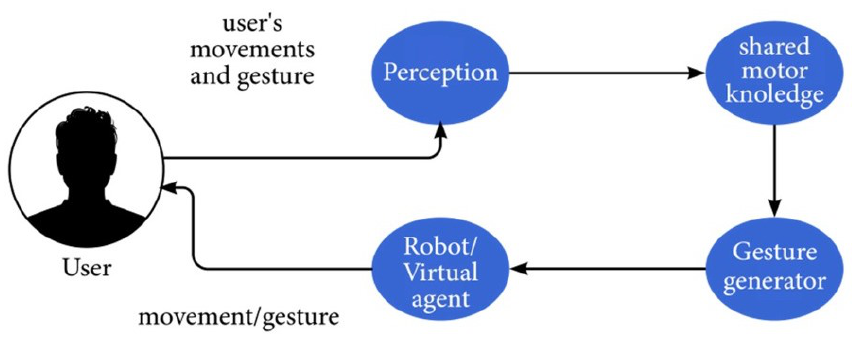
Figure 6. The main components of a physical-based embodied CA.